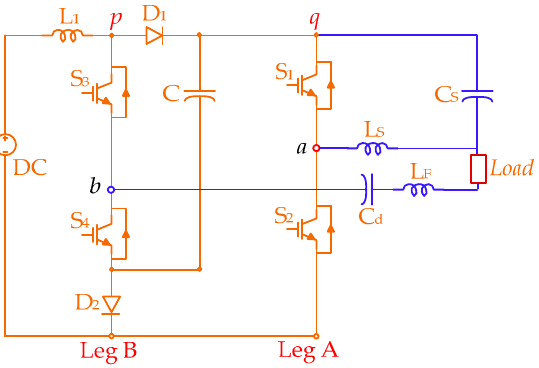
Figure 10. Four-switch quasi-switched boost inverter topology with active power decoupling.